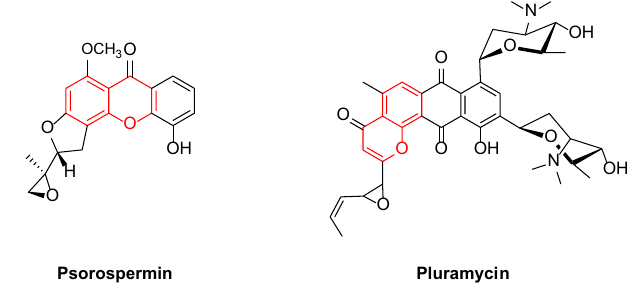
Figure 1. Some pharmacologically important chromene